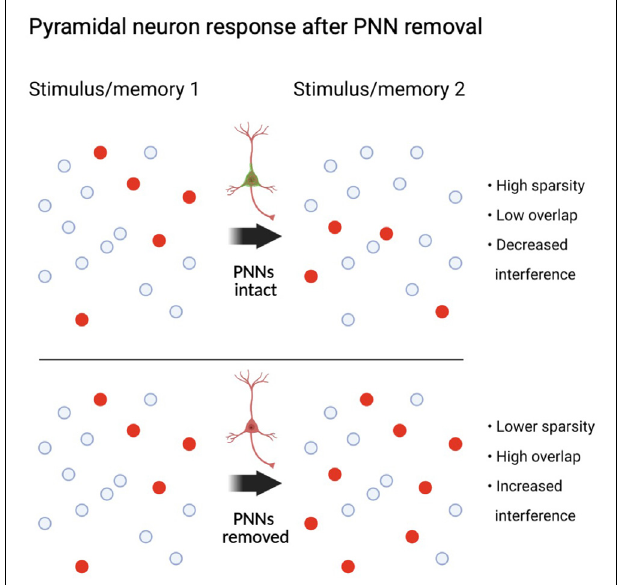
FIGURE 3 | Circuit state following PV interneuron dysfunction after PNN removal. Neural assemblies originally representing a stimulus or memory may overlap when exposed to a similar stimulus or memory if PNNs are removed between the first and second exposure. Summary is based on PV interneuron specific manipulations and circuit functions (see “Role of PV Interneurons in Pattern Separation and Sparse Encoding” section). Created with